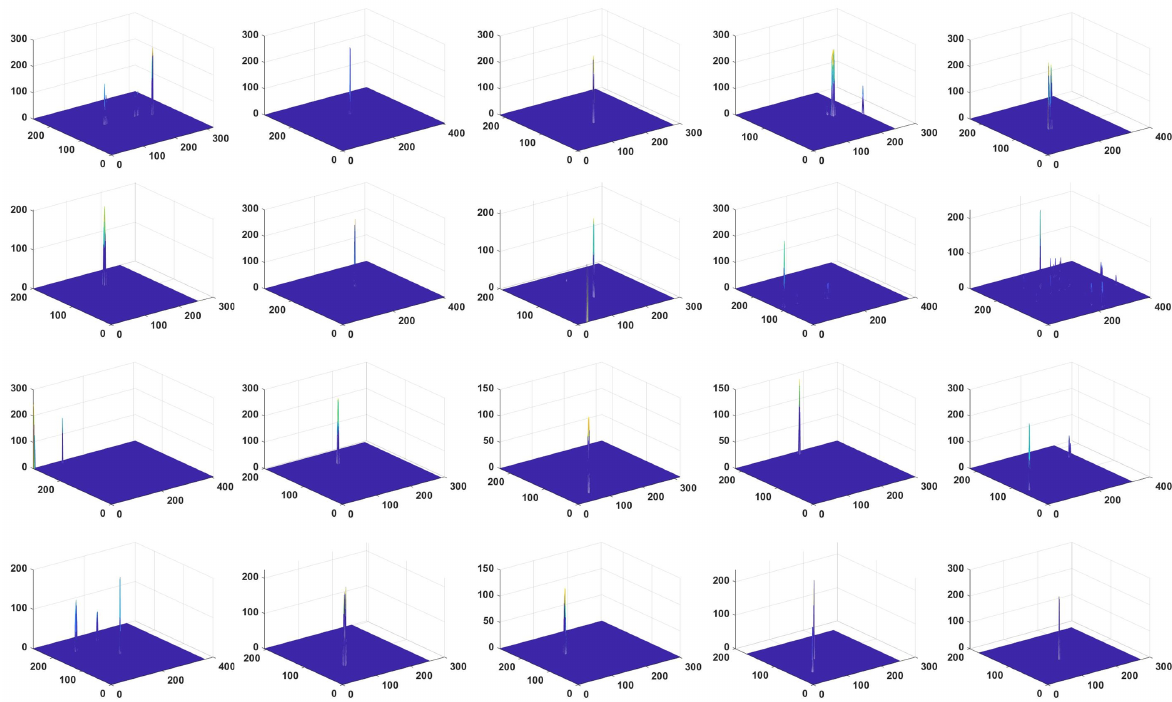
Figure 12. 3D maps of PSTNN on the 20 single-frame